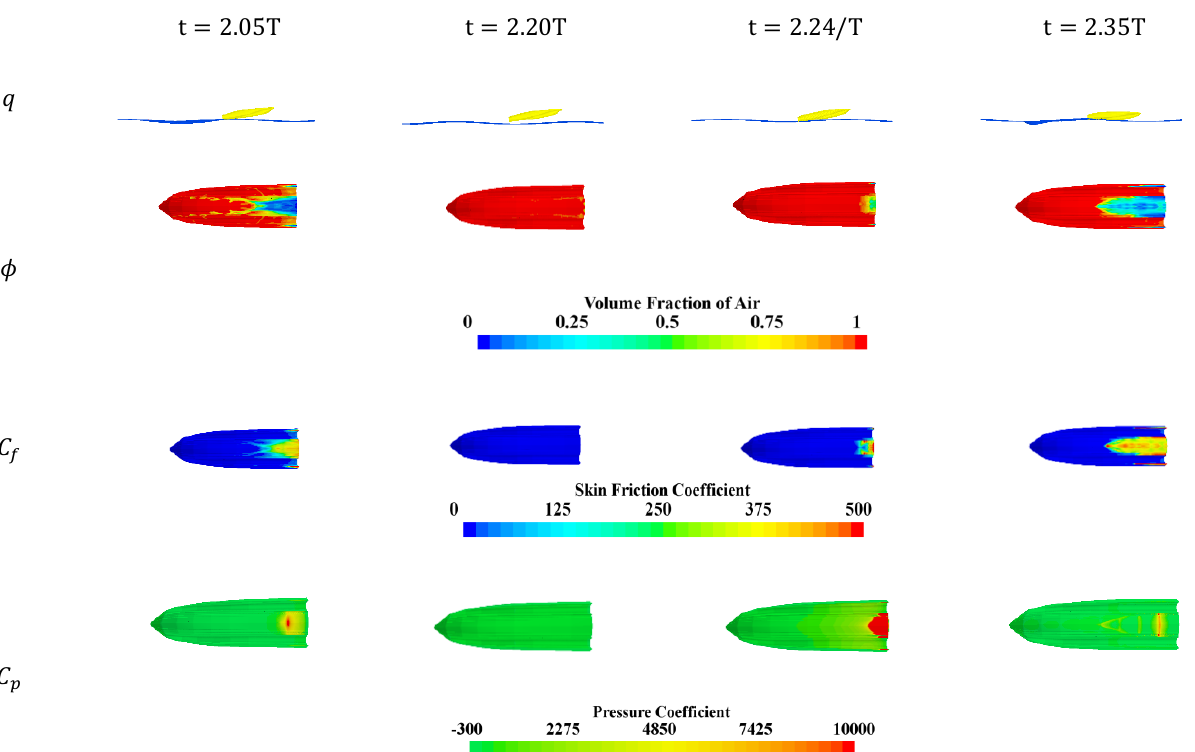
Figure 17. The second fly-over motion of Model B happens at the highest speed, corresponding with a Froude number of 5.6.